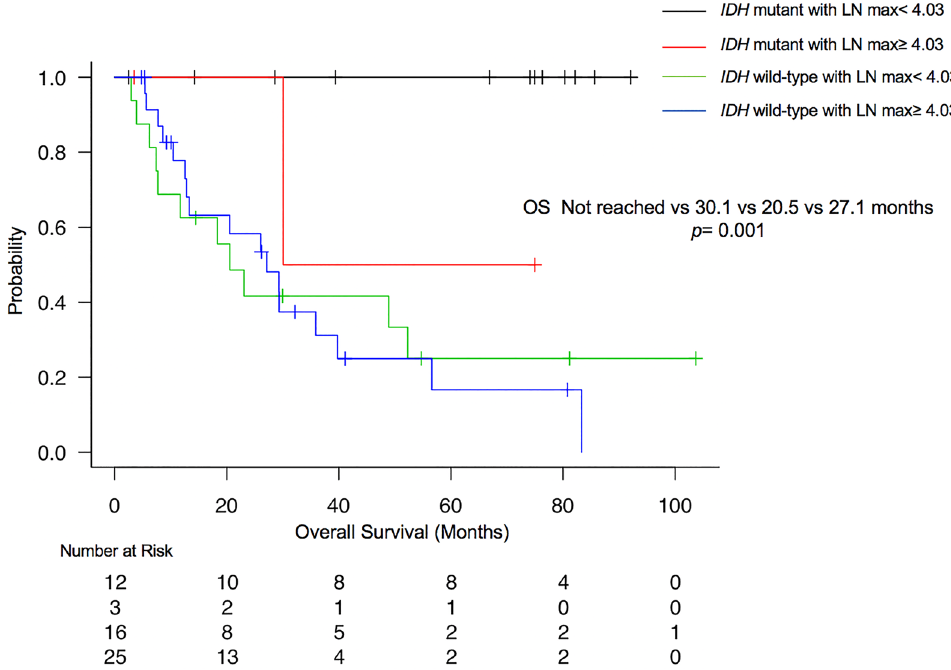
Figure 3. Kaplan–Meier plot of the OS in relation to the IDH status/LN max classification. A significant difference in OS existed between patients with IDH mutant/LN max < 4.03 and those with IDH mutant/LN max ≥ 4.03 ( p = 0.034), although no significant difference in OS was evident between patients with IDH mutant/ LN max ≥ 4.03 and those with IDH wild-type/LN max < 4.03 ( p = 0.40), or between patients with IDH wild-type/ LN max < 4.03 and those with IDH wild-type/LN max ≥ 4.03 ( p =